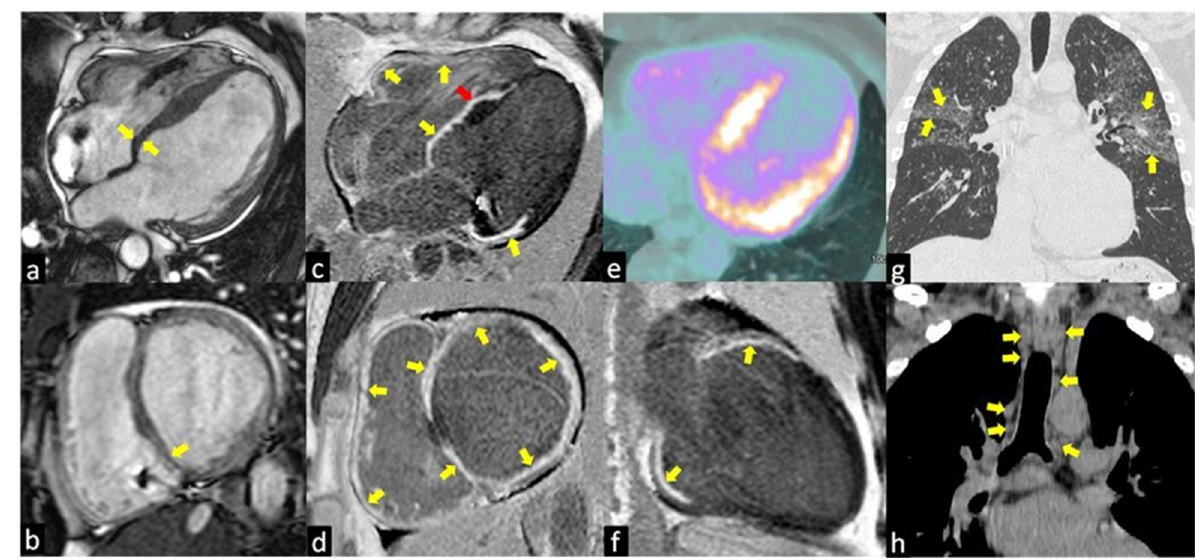
Figure 1. The images show a case of typical Cardiac Sarcoidosis characterized by the presence of LGE of all basal segments of both ventricles (yellow arrows in c , d , f ) with the predominantly transmural distribution involving more than one coronary territory and the right ventricular side of the interventricular septum (red arrow in c ). Bright blood cine sequences show the thinning of the basal septum (yellow arrows in a , b ). Coronal computed tomography (CT) scans show the typical perilymphatic distribution of micronodules with upper lobe predilection (yellow arrows in g ) and hilar and mediastinal bilateral lymphadenopathy (yellow arrows in h ). The 18F-fluorodeoxyglucose positron emission tomography ( e ) revealed an increased uptake in the septal and lateral left ventricle myocardial segments in a patient with systemic sarcoidosis.